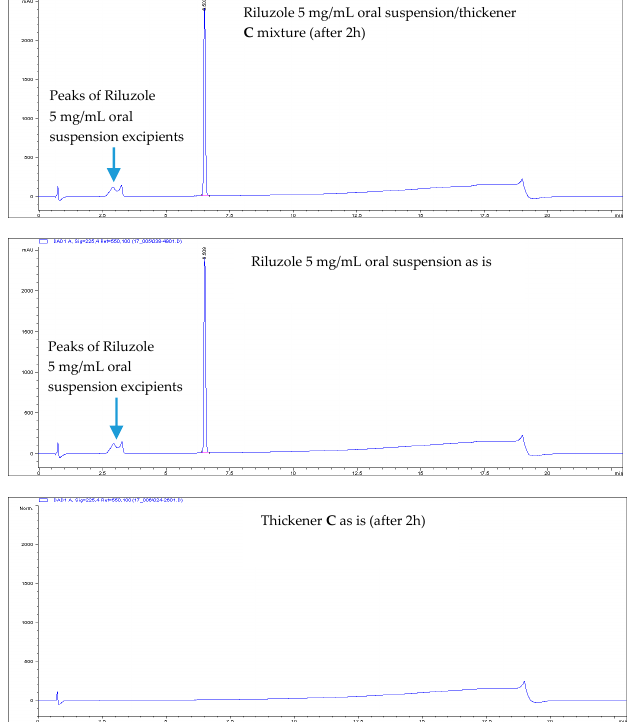
Figure 3 Figure 3. Comparison of chromatograms: Riluzole 5 mg / mL oral suspension / thickener C mixture (after 2 h); Riluzole 5 mg / mL oral suspension as is and Thickener C as is (after 2